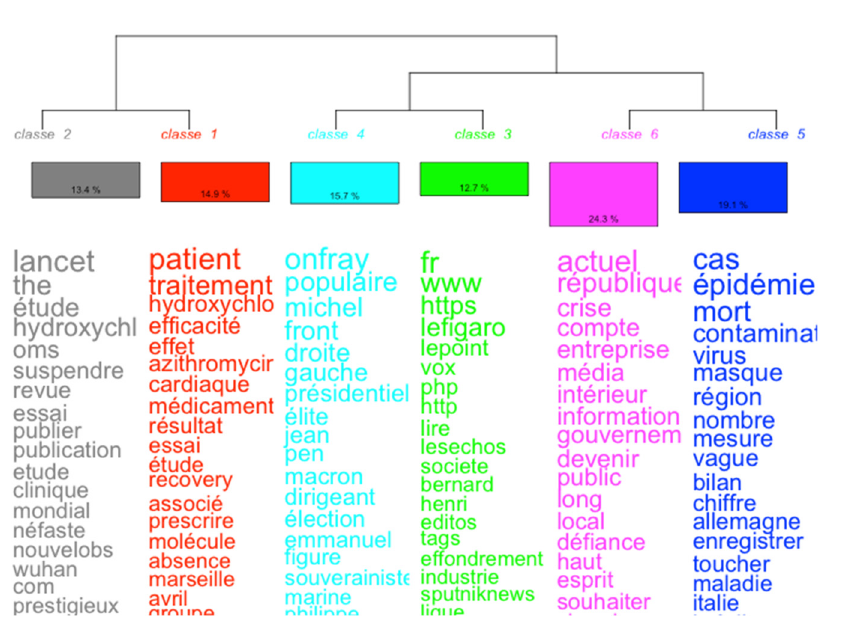
Figure 1. HDC of the press corpus.